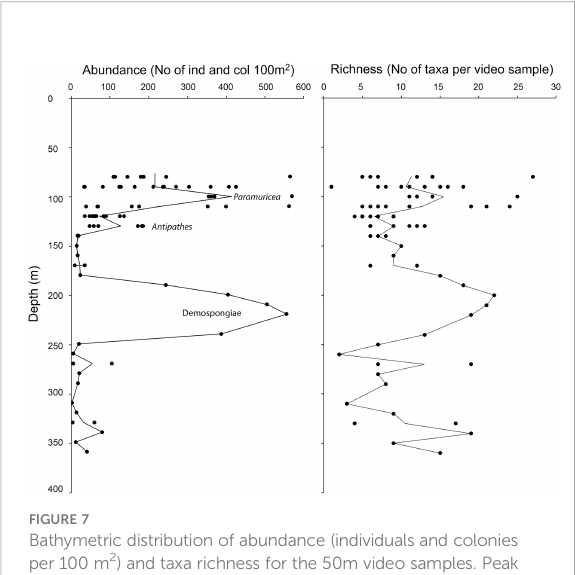
FIGURE 7 Bathymetric distribution of abundance (individuals and colonies per 100 m 2 ) and taxa richness for the 50m video samples. Peak abundance for Paramuricea cf. grayi , Antipathes sp. and sponges (Demospongiae) is indicated. Mean values are indicated with a